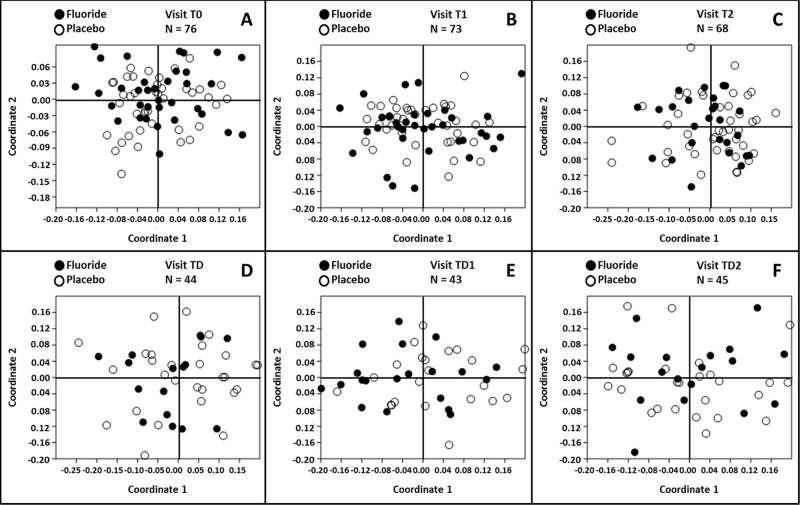
Non-metric multidimensional scaling plots based on the three-dimensional Bray-Curtis similarity index by rinse.The plots are constructed per visit. Subjects receiving rinse A are symbolized by ●, the subject receiving rinse B are indicated with ○. Mouthwashes were administered between visits T0 and TD. The stress for each individual plot is (A) 0.1543, (B) 0.1465, (C) 0.1256, (D) 0.1402, (E) 0.1495 and (F) 0.1531.